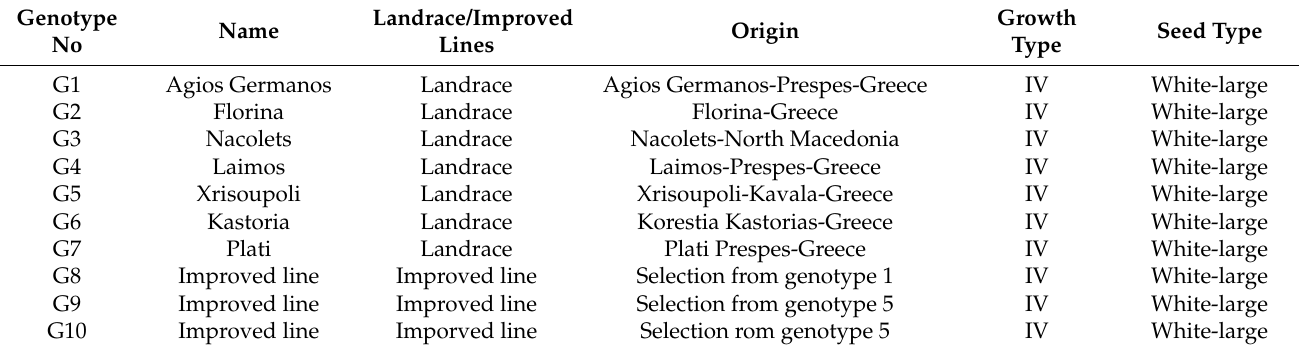
Table 5. Genotype numeration and sources of bean landraces and improved lines evaluated.